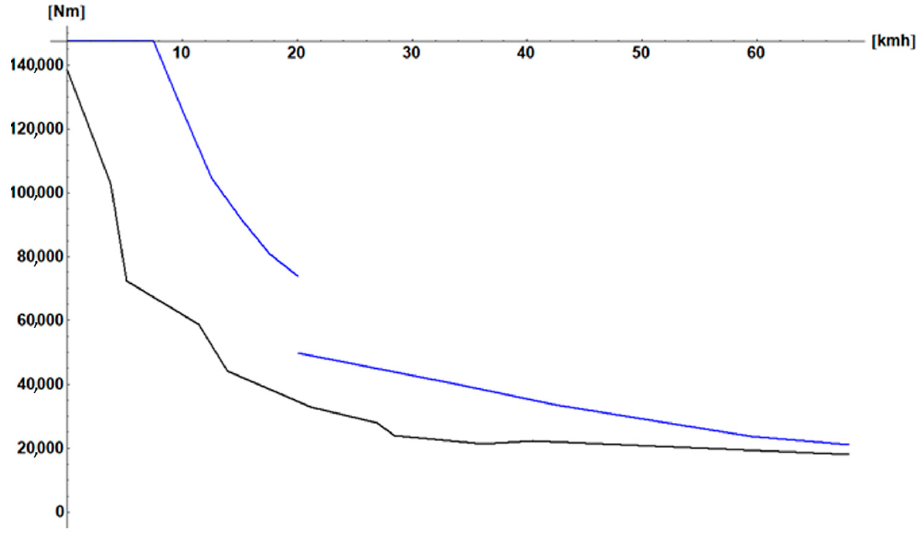
Figure 10. SHEV torque available at sprocket (blue curve, minutes) compared with a traditional ICE- MBT (black curve).